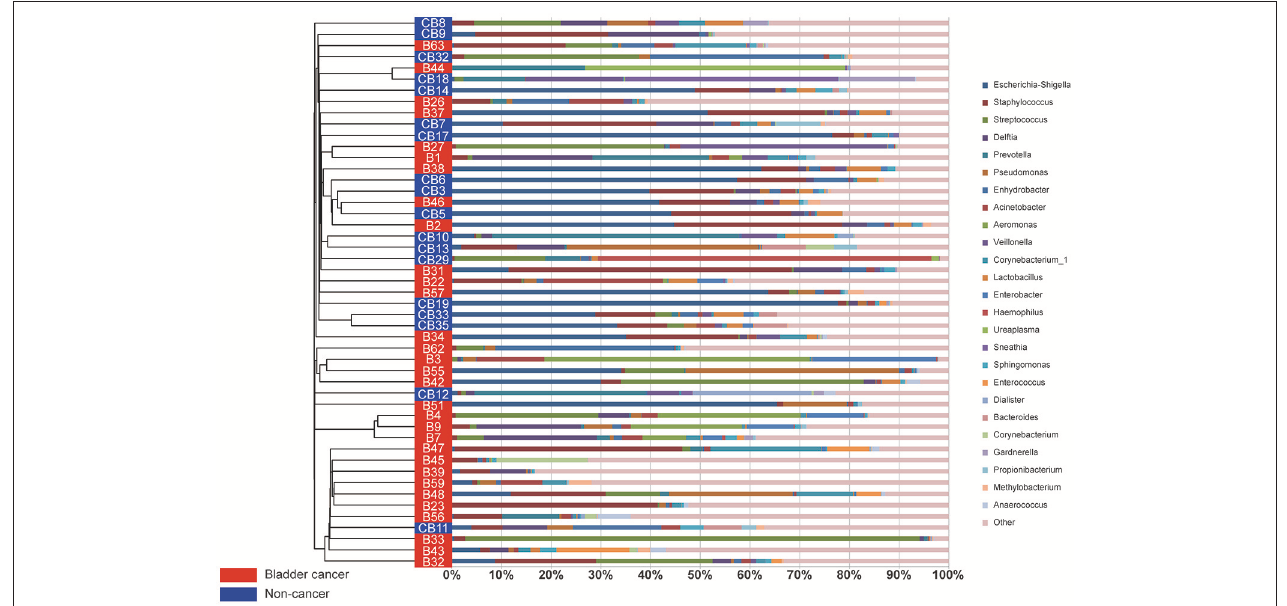
FIGURE 2 | The urinary microbiota profile of participants. A clear hierarchical clustering of cancer samples was observed in the dendrogram at genus level ( left ; based on the unweighted UniFrac distance metric). In the histogram (right) , each colored box represents a bacterial taxon and each bar, a subject. The height of a colored box represents the relative abundance of that organism within the sample. Bacterial genera with a relative abundance < 0.5% and unclassified genera are grouped as